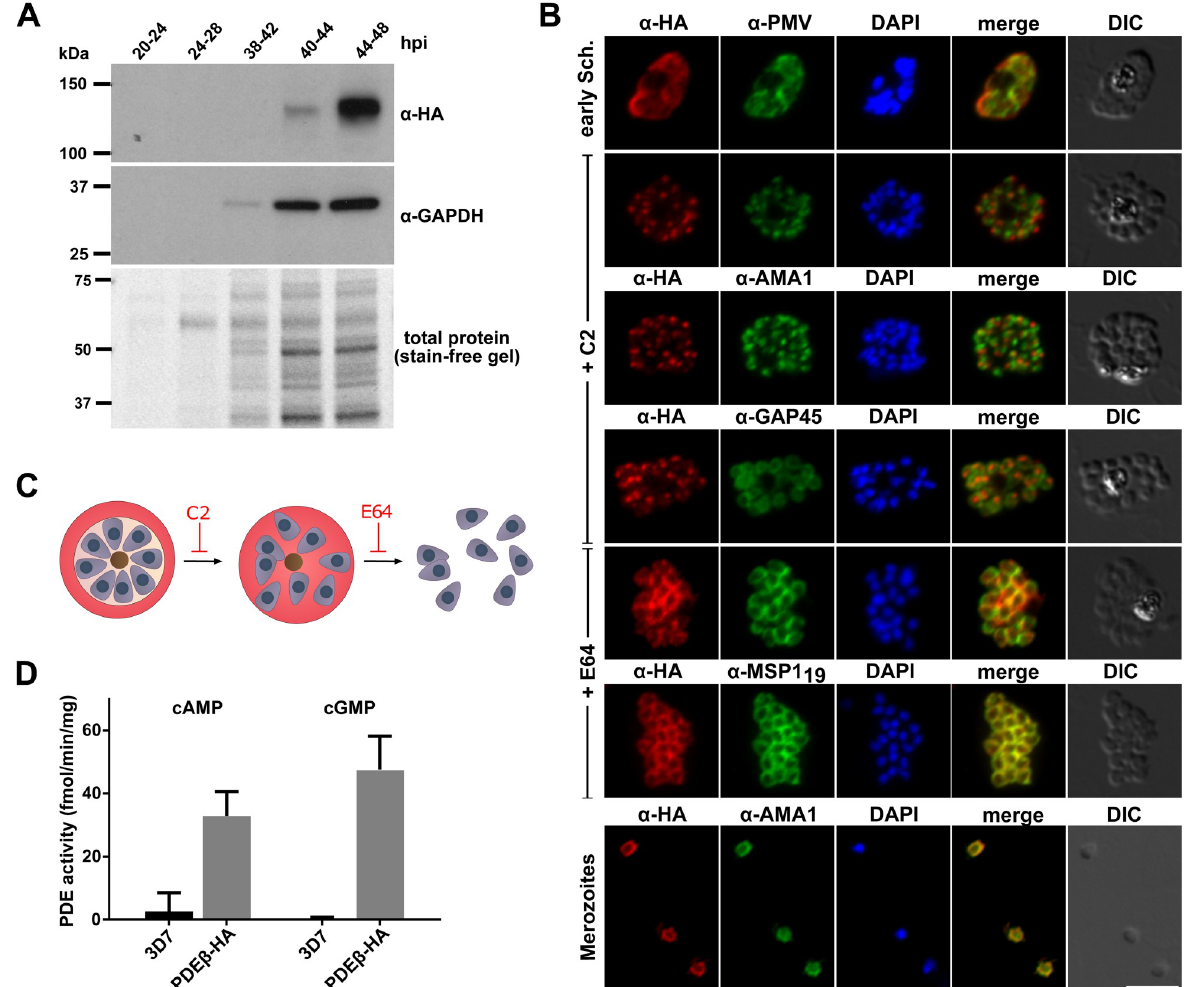
Fig 1. PfPDE β is a dual-specific PDE that translocates from an apical location to the merozoite plasma membrane. (A) Western blot showing a time course of PfPDE β -HA expression in the Plasmodium falciparum blood stage cycle. Parasites were harvested at the indicated hours post invasion (hpi). Equal parasite numbers were loaded in each lane. Positions of molecular weight markers are indicated. (B) Colocalisation in schizonts by IFA (following inhibitor treatment, left) of PfPDE β -HA (red) with markers of specific subcellular compartments (green): plasmepsin V (PMV; ER marker), AMA1 (microneme marker), GAP45 (IMC marker), and MSP1 19 (plasma membrane marker). Nuclear material was visualised by DAPI staining (blue). Merged red and green channels are shown (merge) and a DIC microscopy image is shown to the right. Scale bar, 5 μ m. (C) Schematic showing the effects of Compound 2 and E64 on merozoite egress. (D) Hydrolytic activity (fmol product/minute/mg substrate) of PfPDE-HA affinity-purified from parasite extracts, using either cAMP or cGMP as substrate. Activity of control pull-downs from similarly prepared extracts of wild-type P . falciparum (3D7) are also shown. Data are means from three biological replicates, each performed in triplicate. Error bars, SEM. AMA1, apical membrane antigen-1; cAMP, cyclic AMP; cGMP, cyclic GMP; C2, Compound 2; DIC, differential interference contrast; ER, endoplasmic reticulum; GAPDH, glyceraldehyde 3-phosphate dehydrogenase; GAP45, glideosome-associated protein 45; HA, haemagglutinin; hpi, hours post invasion; IFA, immunofluorescence assay; IMC, inner membrane complex; MSP1 19 , merozoite surface protein 1 19 ; PDE, phosphodiesterase; PfPDE β , Plasmodium falciparum phosphodiesterase beta; PMV, plasmepsin V.